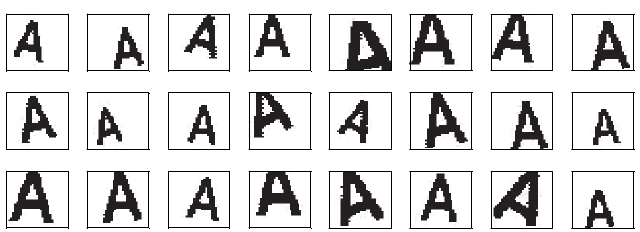
Fig. 1. The first class (category of the letter “A”) is represented with 2,000 variously distorted 32 32  images [38]. The image background is pure